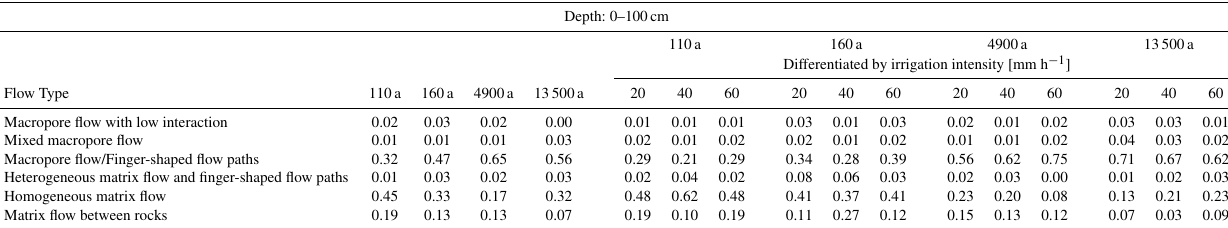
Table A1. Relative frequencies of flow type occurrence for the profile depth of 100cm. Left: listed for each age class. Right: differentiated by irrigation intensity for each age